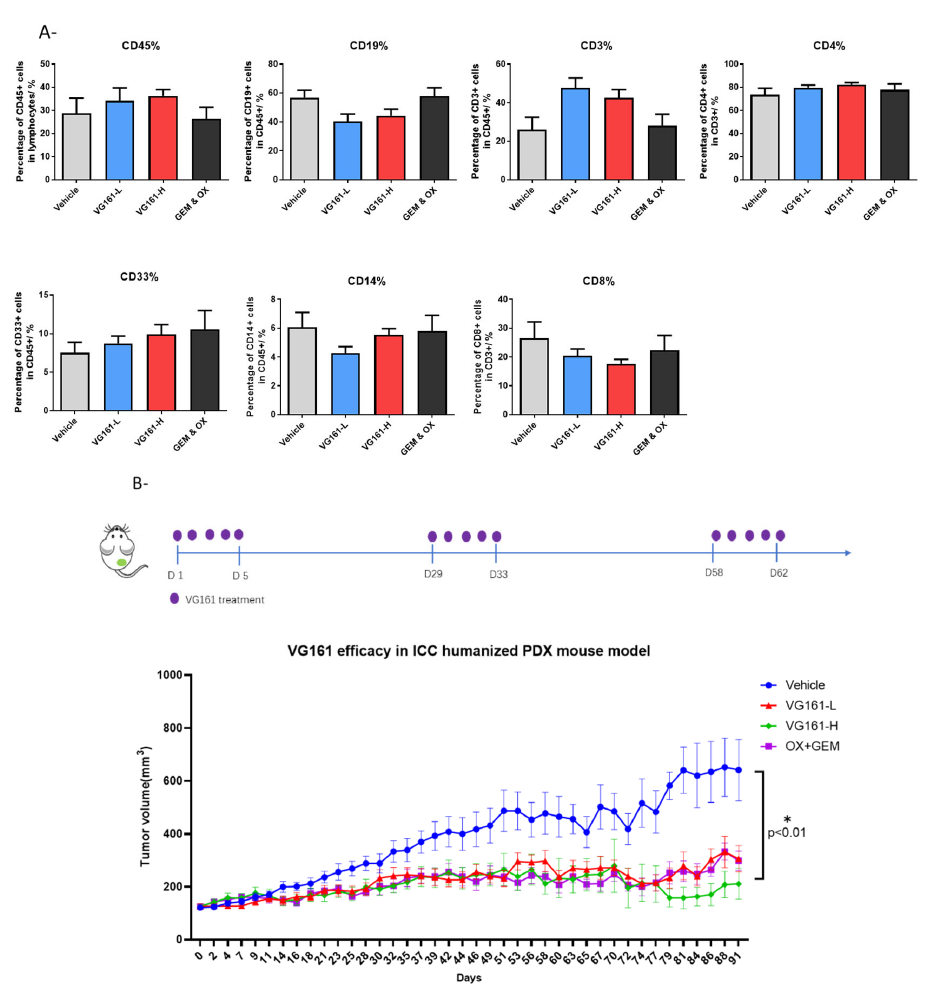
Figure 3. Humanized ICC PDX model. ( A ) Implantation of different human white blood cells in the different mouse groups before treatment. ( B ) Tumor size after administering VG161 to female Hu-NPI mice bearing patient tumor tissue. Data points represent group mean; error bars represent standard error of the mean (SEM).